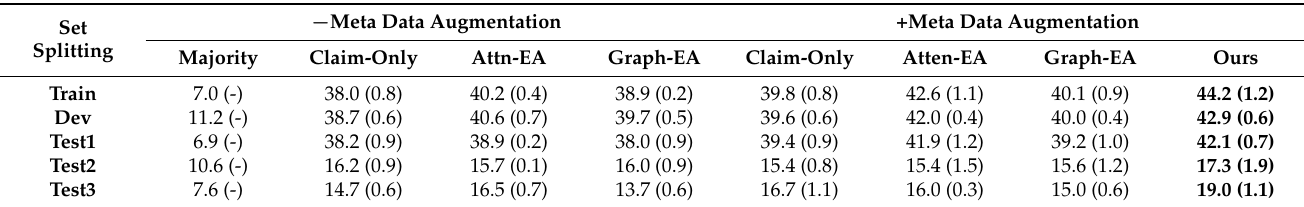
Table 2. Average F1 scores (standard deviations) evaluated in the experiences. − Meta Data Augmentation Set Splitting